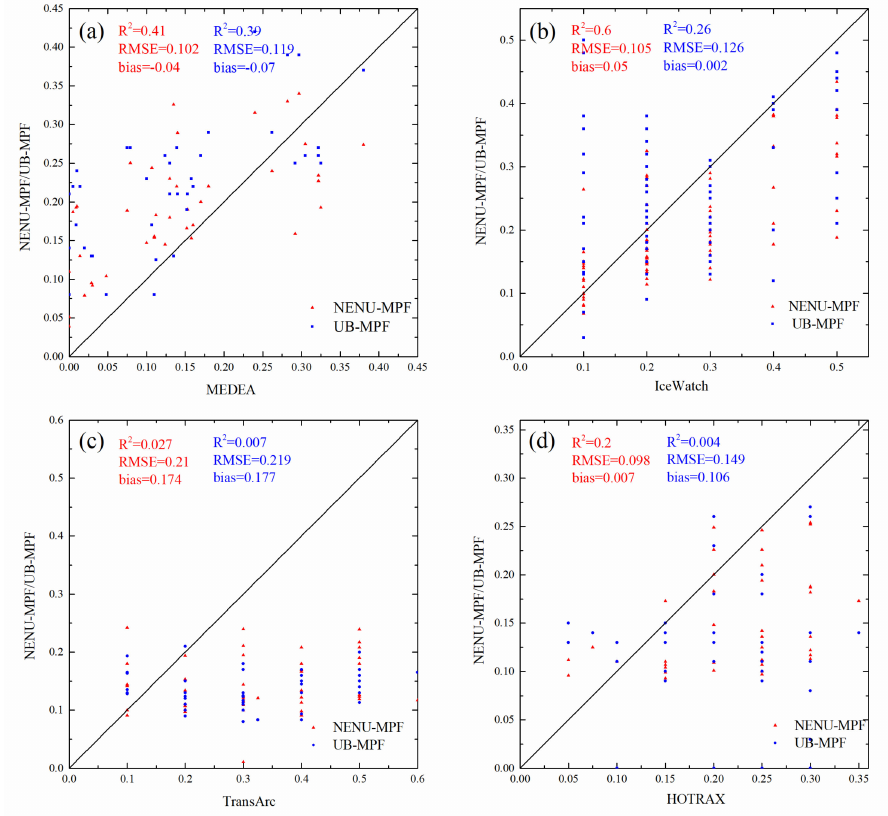
Figure 14. Validation of the NENU-MPF dataset against the ( a) MEDEA, ( b ) IceWatch, ( c ) TransArc, and ( d ) HOTRAX